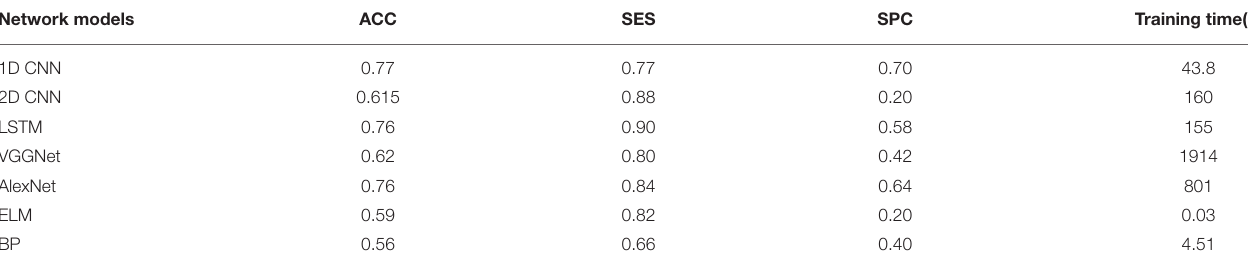
TABLE 4 | Results on combined walking and running data set. Network